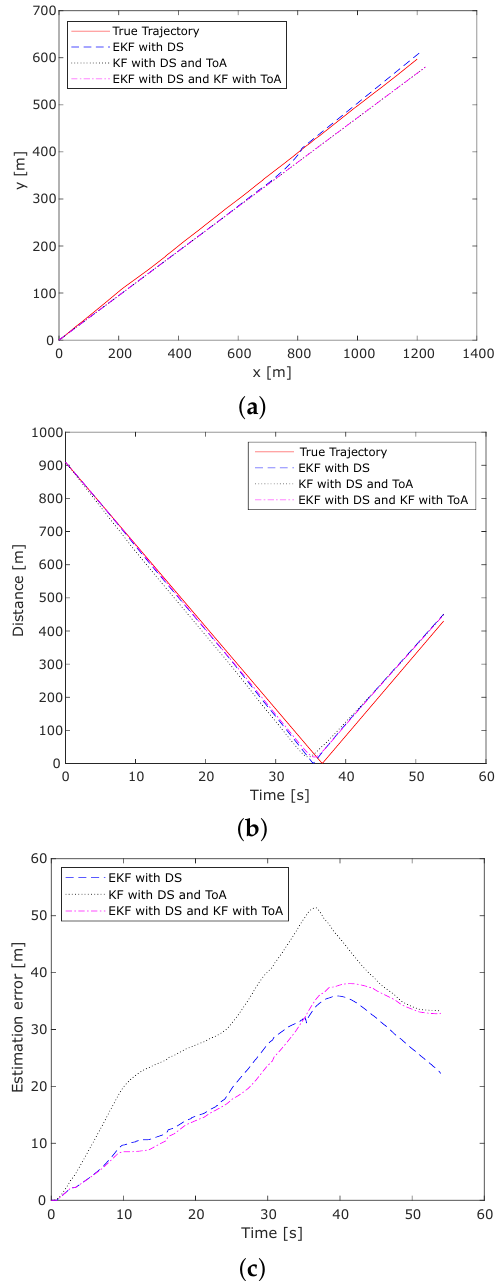
Figure 3. ( a ) True and estimated vehicle trajectory, ( b ) Distance between transmitter and receiver, and ( c ) Estimation error, when using Extended Kalman Filter on Doppler measurements (EKF DS), Kalman Filter on individual time and Doppler measurements (KF DS and ToA), and the combination of two previous approaches (EKF DS and KF ToA), while the vehicle is driving in the tunnel